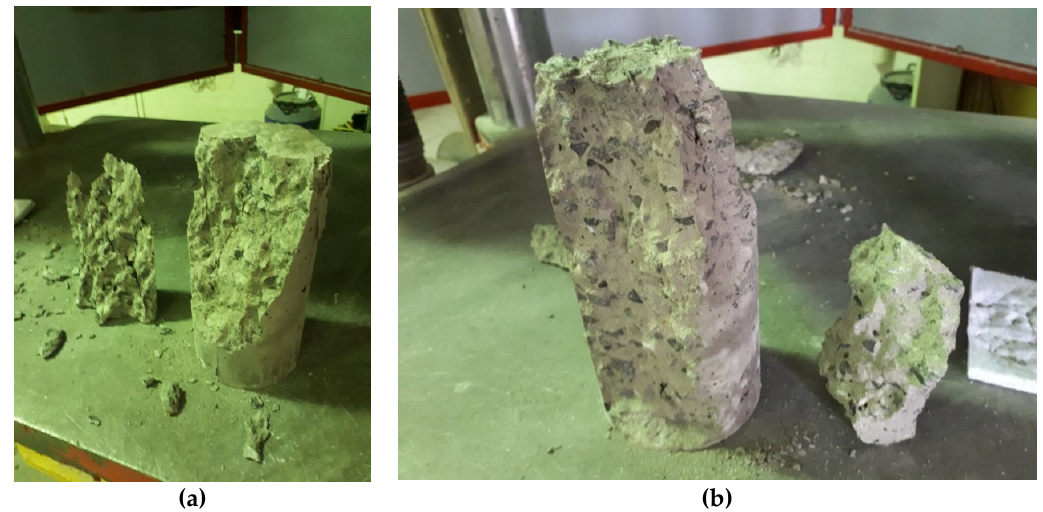
Figure 15. (a,b) Partial cone/shear failure of samples subjected to compression testing.